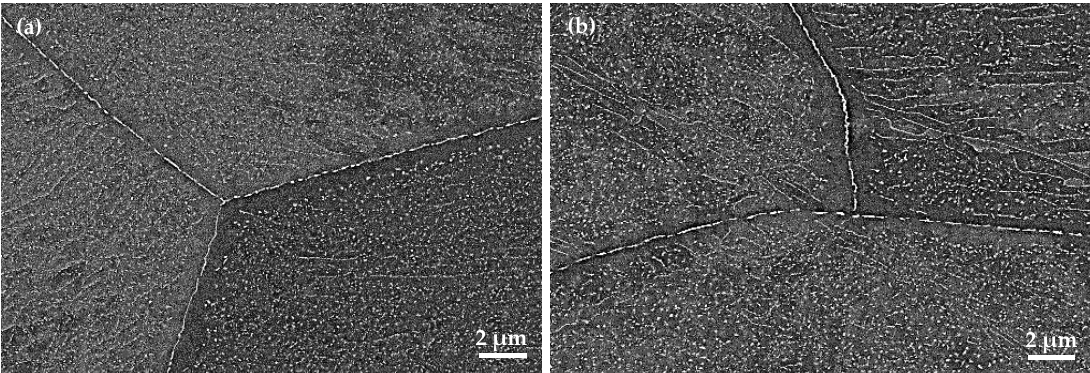
Figure 6. Representative SEM ‐ BSE micrographs of thermomechanically induced Laves phase evolution of model alloys (a) Fe17Cr2.6W and (b) Fe17Cr3.6W created by deformation at 800 °C, deformation grade of 0.5, and isothermal tempering after the deformation at 800 °C for 60 s. The high ‐ tungsten model alloy Fe17Cr3.6W with a tungsten content of 3.6 wt. % exhibits an